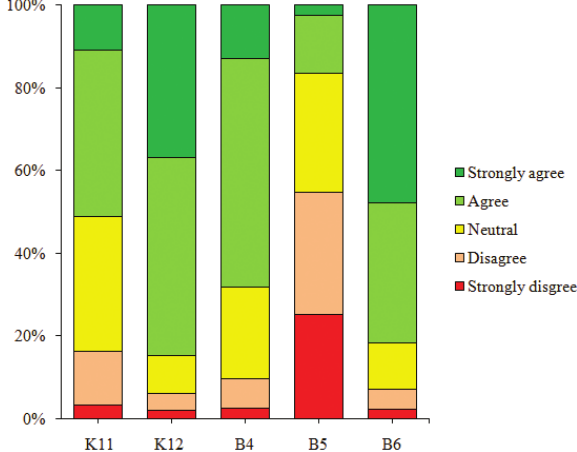
Figure A9. Cumulative responses to K11: “Per unit